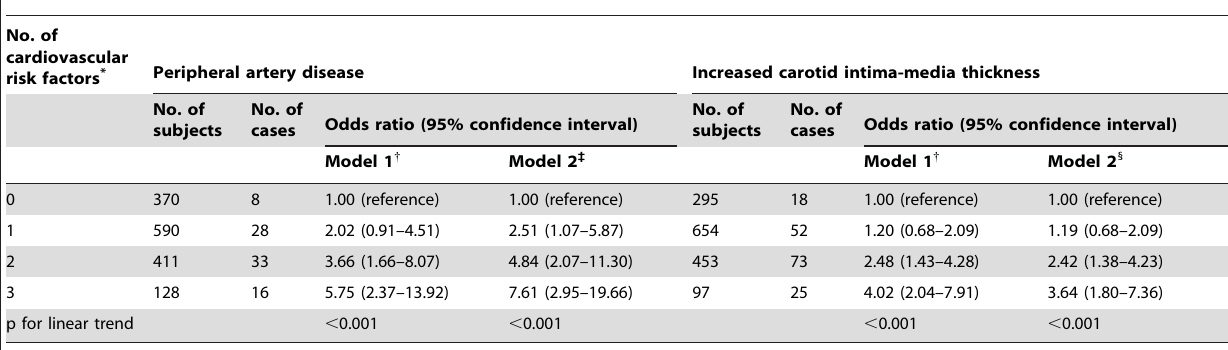
Table 3. Association of peripheral artery disease and increased carotid intima-media thickness with a clustering of cardiovascular risk